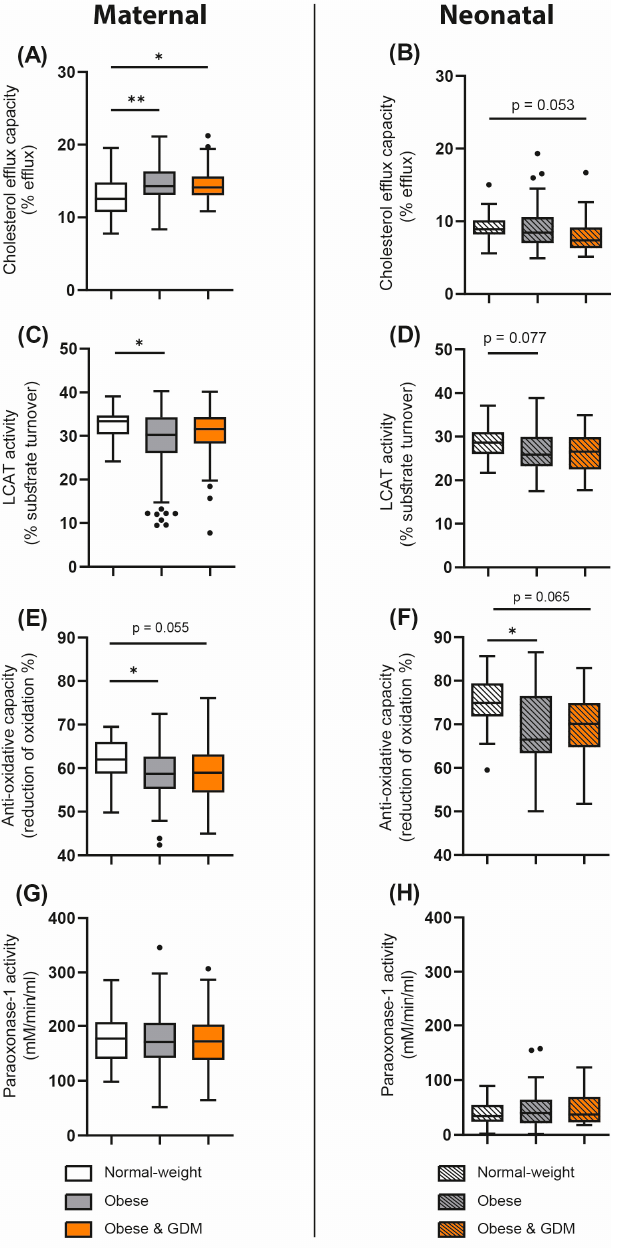
Figure 2. Differences in serum functionalities in normal-weight and overweight/obese pregnant women and in women with GDM and their offspring. Cholesterol efflux capacity was assessed with a cell-based assay ( A , B ). The activity of LCAT in mothers ( C ) and offspring ( D ) was evaluated. Serum antioxidative capacity was assessed in mothers ( E ) as well as in paired umbilical cord blood ( F ). Activity of HDL-associated anti-inflammatory enzyme paraoxonase-1 in mothers ( G ) and neonates ( H ) was evaluated. Data are presented as Tukey boxplots showing the median and interquartile ranges as well as minimum and maximum values and outliers. Differences were analyzed by ANOVA or Kruskal–Wallis test based on the distribution of the variable. * p < 0.05, ** p < 0.01.